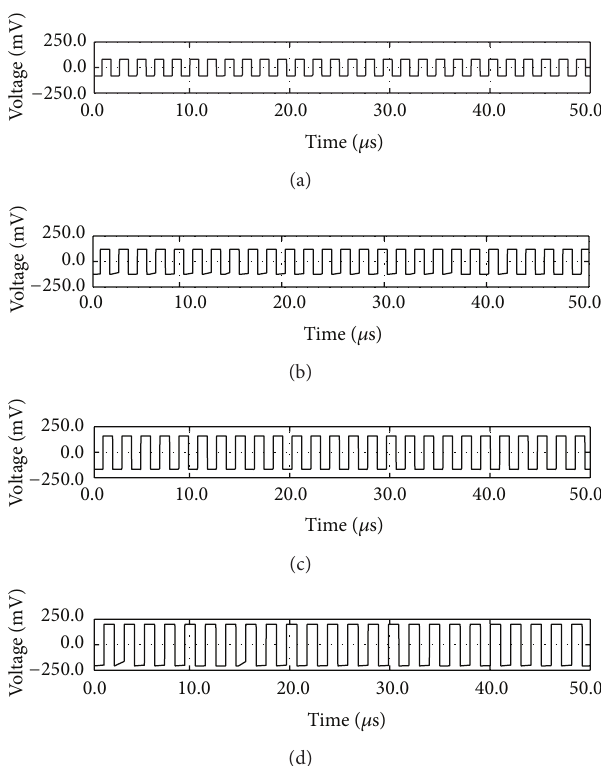
signals: a triangular and a sinusoidal, each one represented as 50 KHz, 150 mV signal. The bias currents 𝐼 are, respectively, set as 20 𝜇 A and 40 𝜇 A. The outputs of delta modulator for triangular and sinusoidal modulating signals are shown in Figures 20 and 21, respectively, and